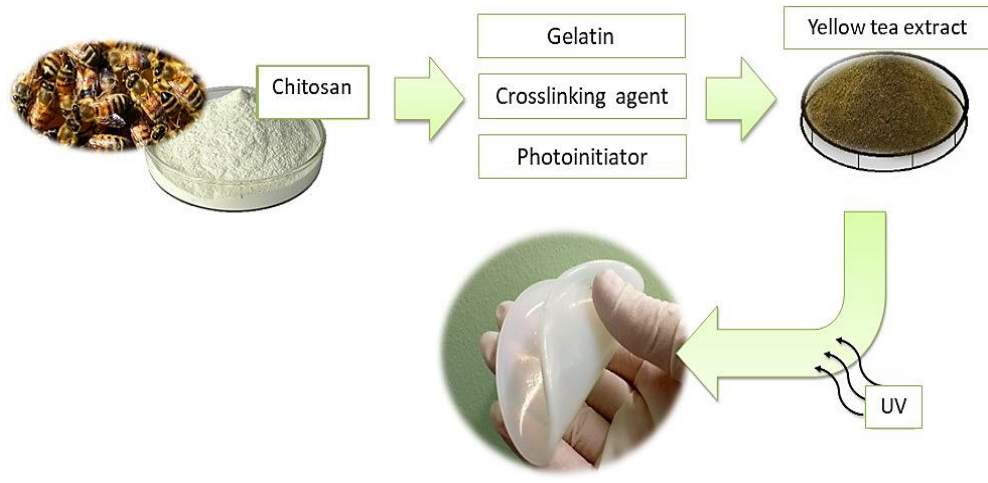
Figure 2. The scheme of the hydrogels’ preparation. Prepared samples were immersed in phosphate-buffered saline (PBS) for 15 min to remove possible unreacted reagents and then dried at 40 ◦ C for 24 h. Next, they were cut into small samples (approx. 1.0 g) and subjected to further